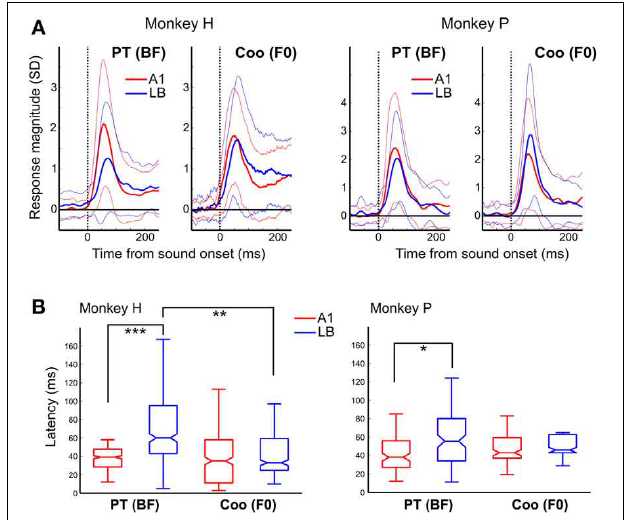
FIGURE 7 | Average response to the pure-tone BF and to coo calls with F0 matched to the BF. (A) PSTH of the responses in A1 (red) and LB (blue) averaged separately across all auditory neurons to their BF (left panel) and to a coo (right panel) whose F0 was matched to the BF. The similarly color-coded thin lines show the standard deviations from the average response. The dotted vertical line indicates sound onset. Latencies to the BF in LB were longer than those to a coo (median ± SE, monkey H: median: 39 vs. 60ms, Q1: 29 vs. 43ms, Q3: 48 vs. 95ms, p < 0 .